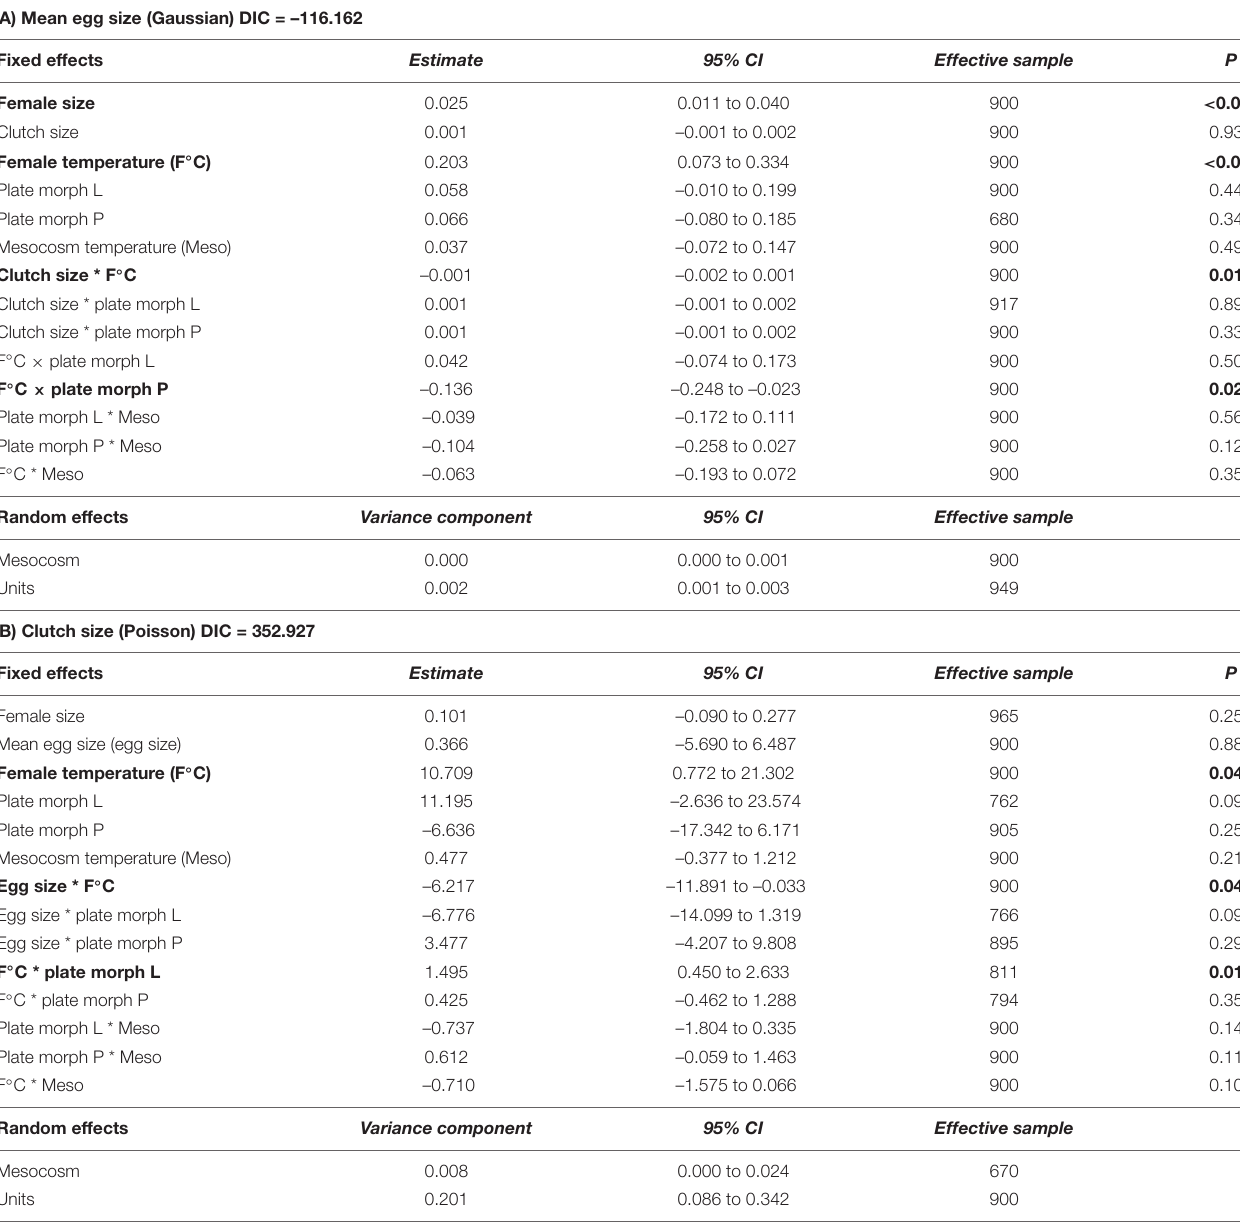
TABLE 2 | Mean egg size (A) and clutch size (B) of stickleback ( Gasterosteus aculeatus ) females of differing lateral plate morph (C, complete; L, low; P, partial) depending on acclimation temperature (F ◦ C) and environmental (mesocosm)